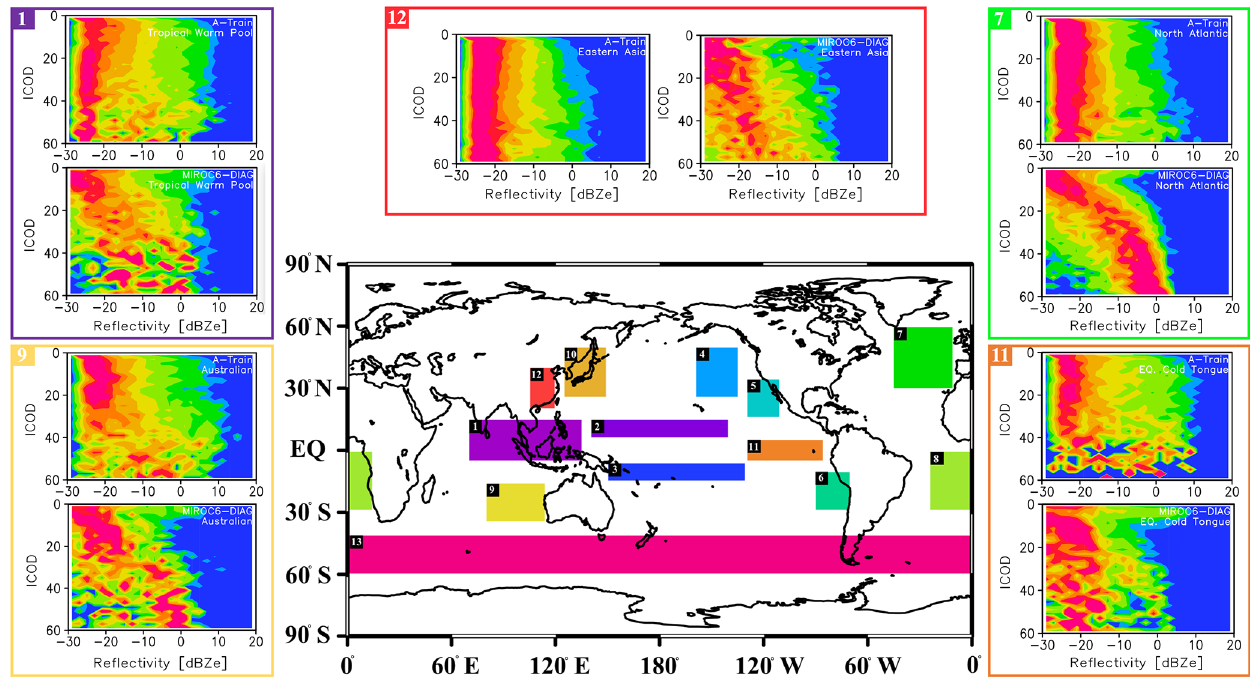
Figure 4. Definition of the 13 regions used in the post-process package. An example of the regional CFODD analysis over the (red) Eastern Asian, (purple) Tropical Warm Pool, (yellow) Australian, (green) North Atlantic, and (orange) Equatorial Cold Tongue regions obtained from the MIROC6–COSP2 and the A-Train observations for the R e range 5 < R e < 12µm. The color scale is the same as in Fig.